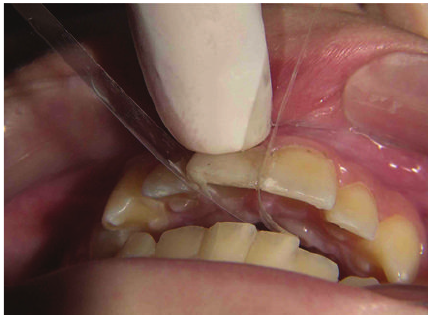
Figure 6: Reattachment of the tooth fragment with a flow resin.